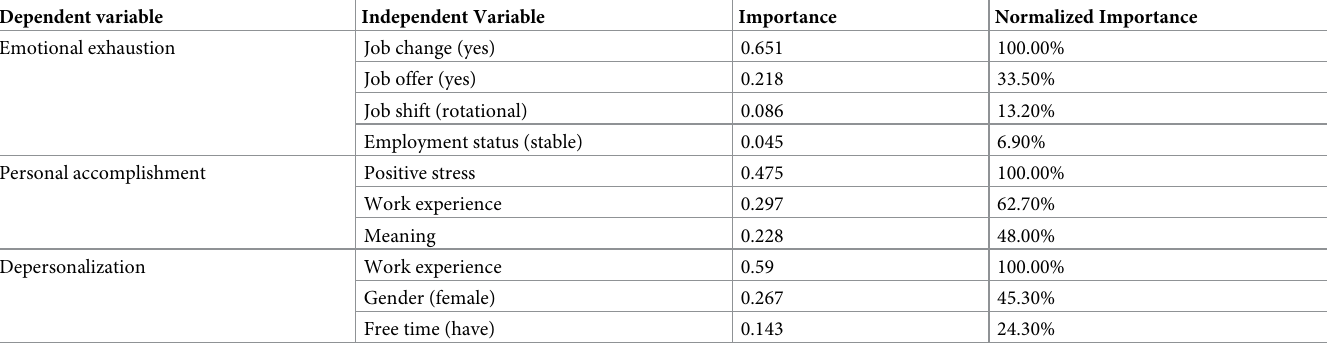
Table 5. NN analysis to assign the importance of